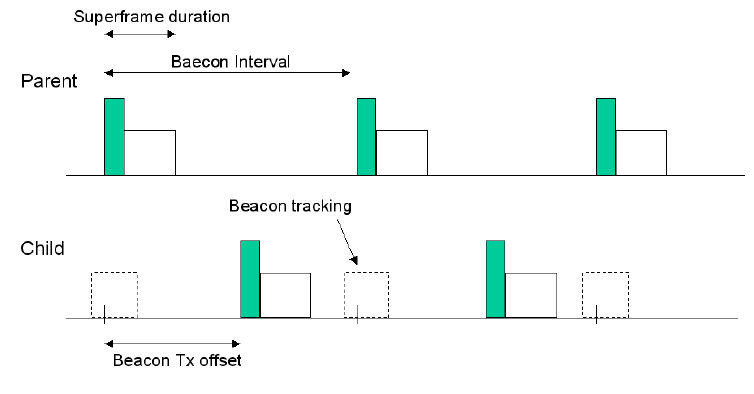
Figure 9. The tracking of the beacon’s parent, performed by a generic